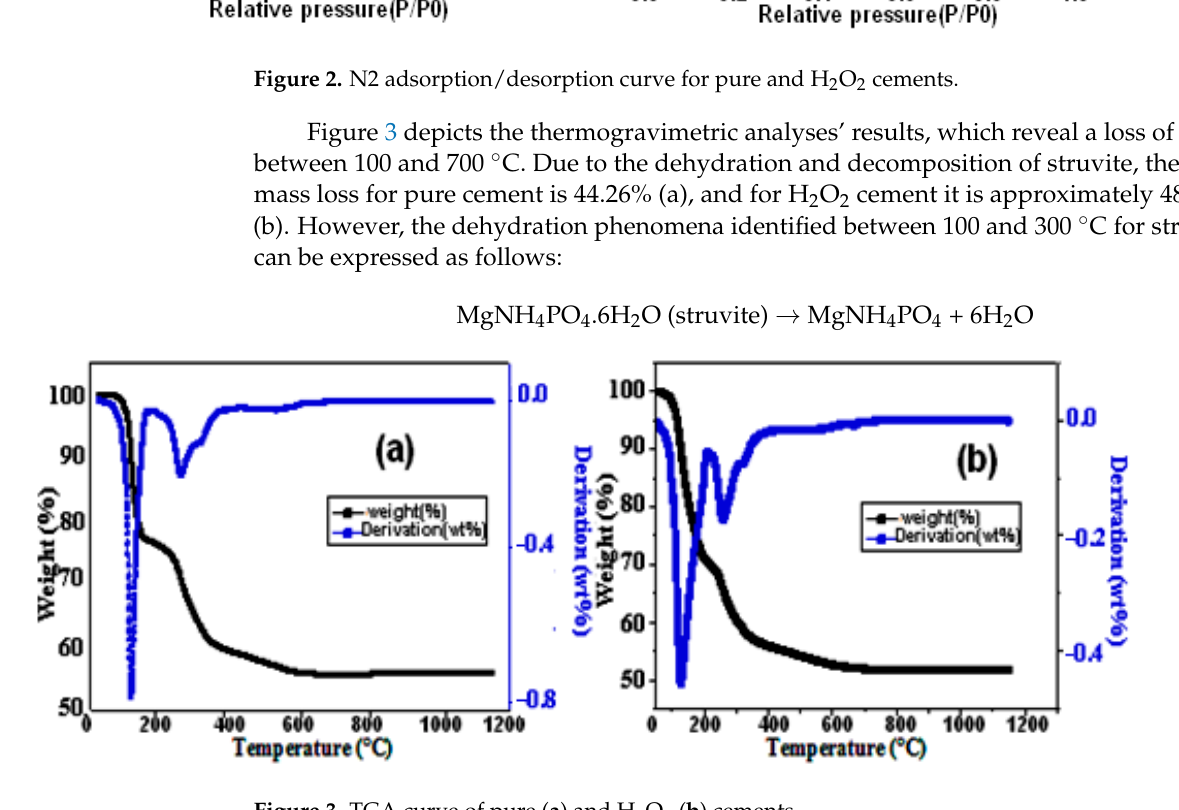
Figure 2. N2 adsorption/desorption curve for pure and H 2 O 2 cements.